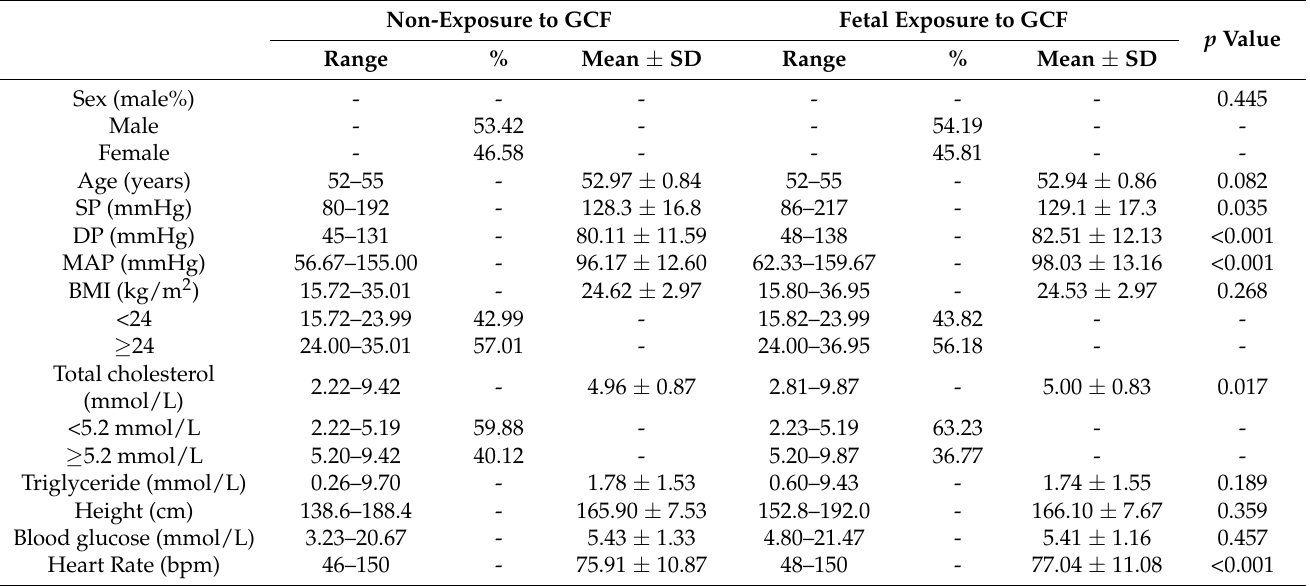
Table 1. Cardiovascular and blood values between the exposure and non-exposure groups.